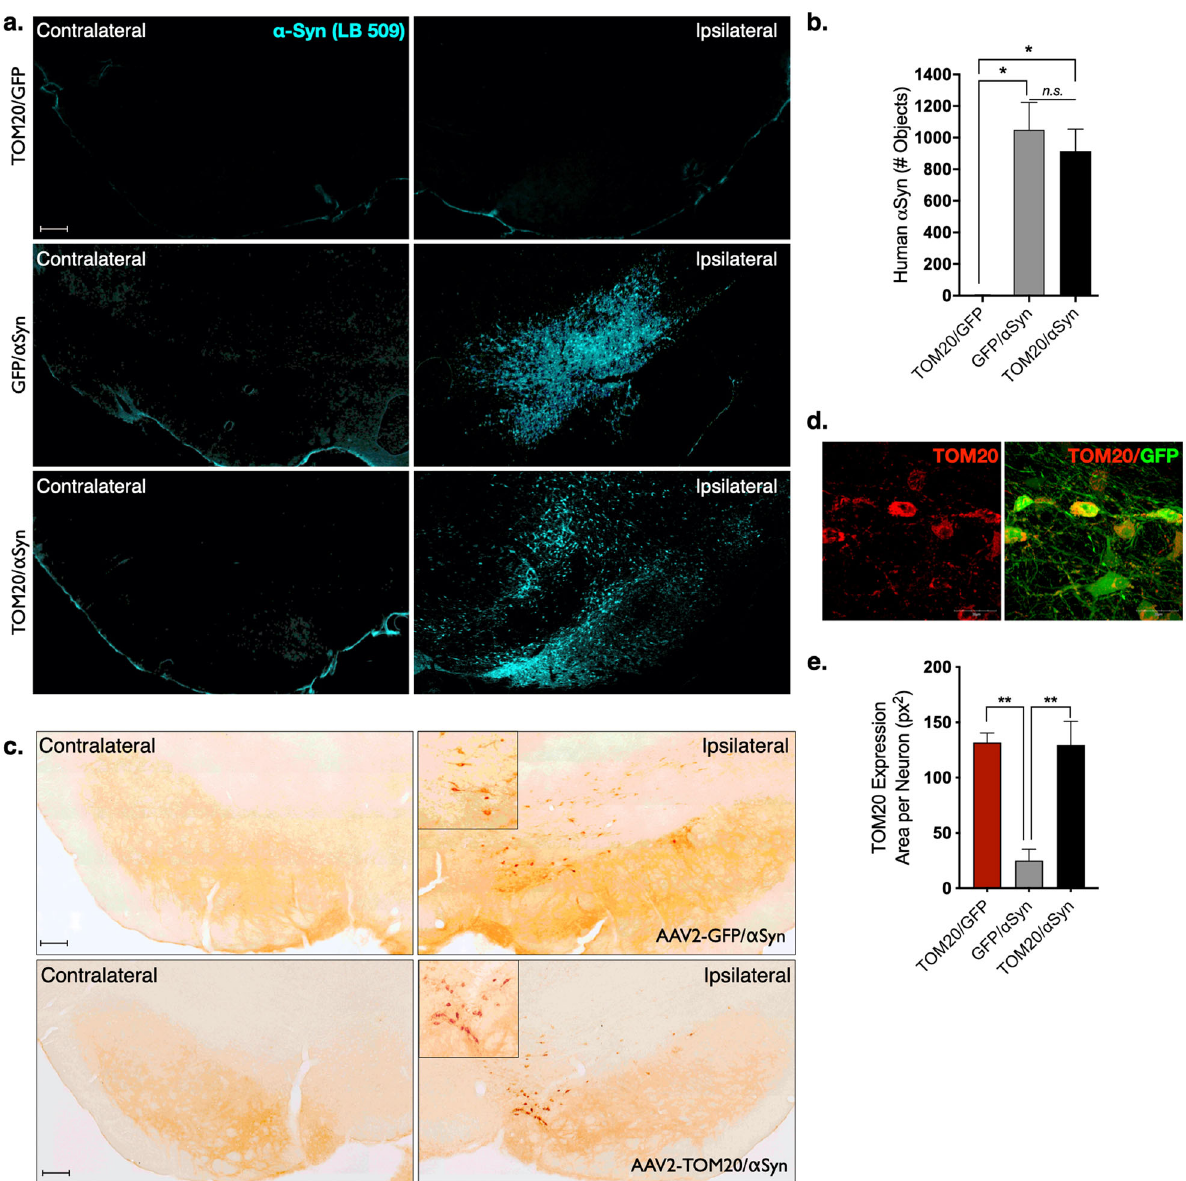
Fig. 2 Vector co-administration does not substantially alter target protein expression. Human α Syn protein expression was detectable within the injected hemisphere of AAV2- α Syn/GFP and AAV2-TOM20/ α Syn and was expressed at similar levels in both treatment groups receiving the human α Syn vector; (F(2, 26 = 4.6), p = 0.0192, ANOVA); scale bar 100 μ m ( a , b ). Insoluble α Syn (proteinase K resistant) was con fi rmed in animals injected with AAV2- α Syn vectors; representative image from AAV2-TOM20/ α Syn; scale bar 100 μ m ( c ). AAV2-TOM20 vector infusion resulted in signi fi cantly elevated levels of TOM20 within neurons of the ventral midbrain, which was not affected by co-expression of AAV2- α Syn; (F(2, 6 = 17.5), p = 0.0031, ANOVA; d , e ). Error bars depict standard error of the mean